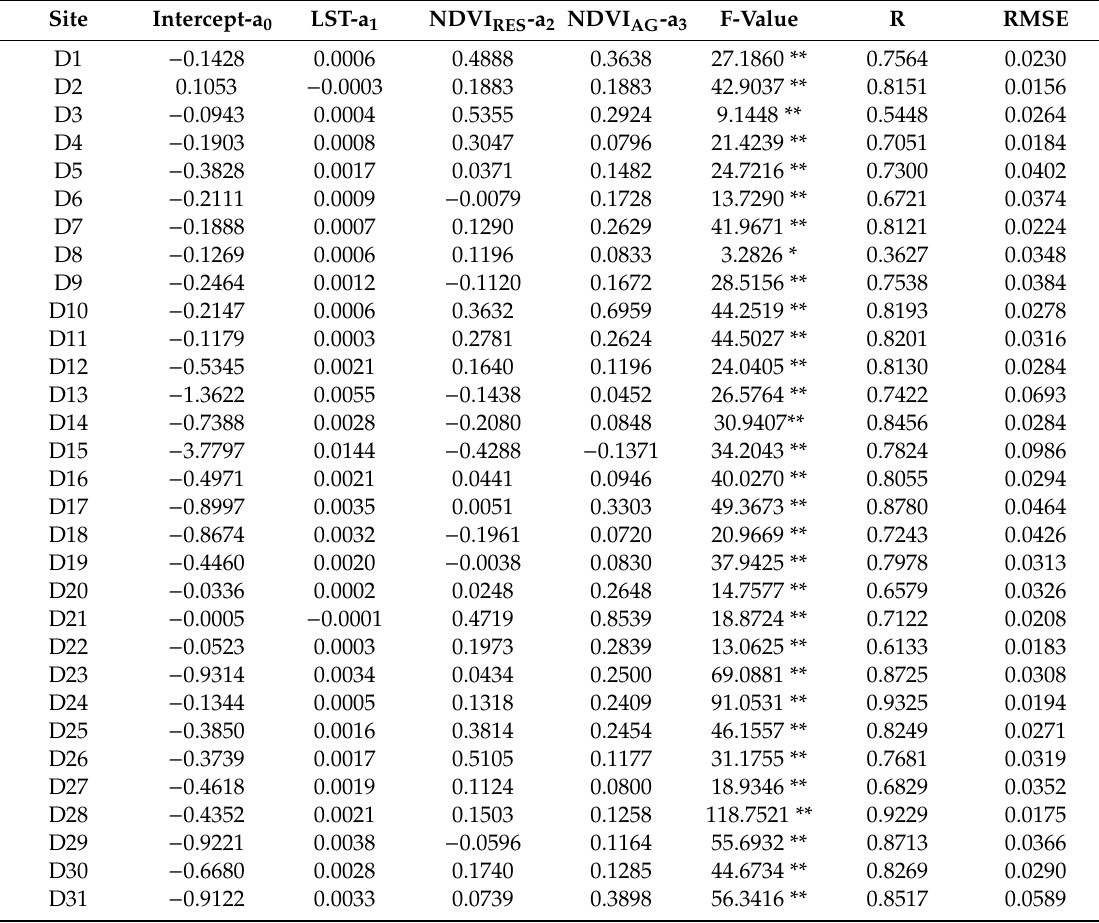
Table 2. Layer soil moisture estimation model (0–10